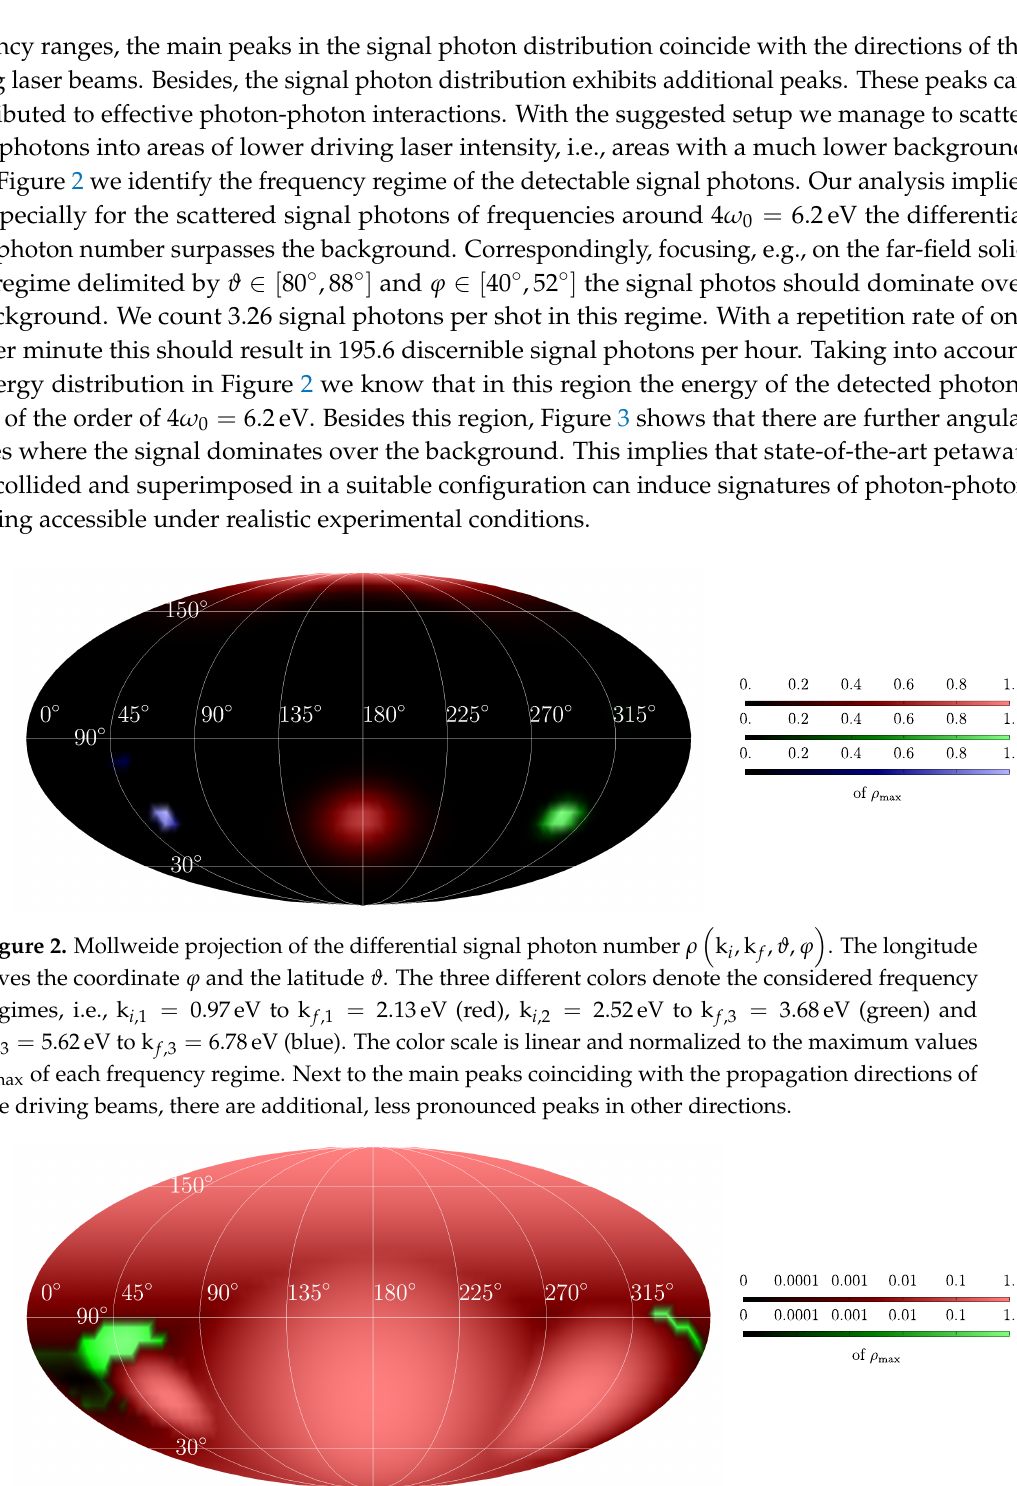
Figure 3. Mollweide projection of the differential number of signal photons and driving laser photons in the all-optical regime. The longitude gives the coordinate ϕ and the latitude ϑ . In the red shaded areas the driving laser photons dominate, while in the green shaded areas the signal photons dominate. The color scale is logarithmic and normalized to the maximum values ρ max of each type of